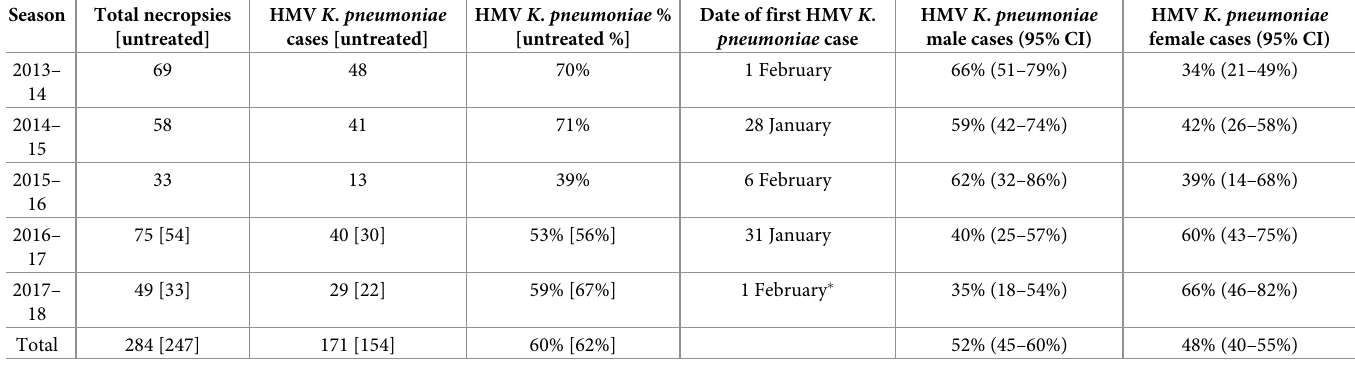
Between 2013 and 2018, HMV K . pneumoniae infection constituted the majority of pup mor- tality at Sandy Bay (Fig 4) with a mean annual prevalence of 60.2% (n = 171; Tables 2 and 3). Exclusion of ivermectin-treated dead pups to remove the effects of treatment from the analysis results in a mean prevalence of 62.3%. All cases in this category exhibited gross and histological lesions consistent with HMV K . pneumoniae infection [7], and cultured a predominant growth Table 2. Summary of annual proportions of HMV K . pneumoniae deaths in New Zealand sea lion ( Phocarctos hookeri ) pups necropsied at Sandy Bay, Enderby Island for field seasons between 2013 and